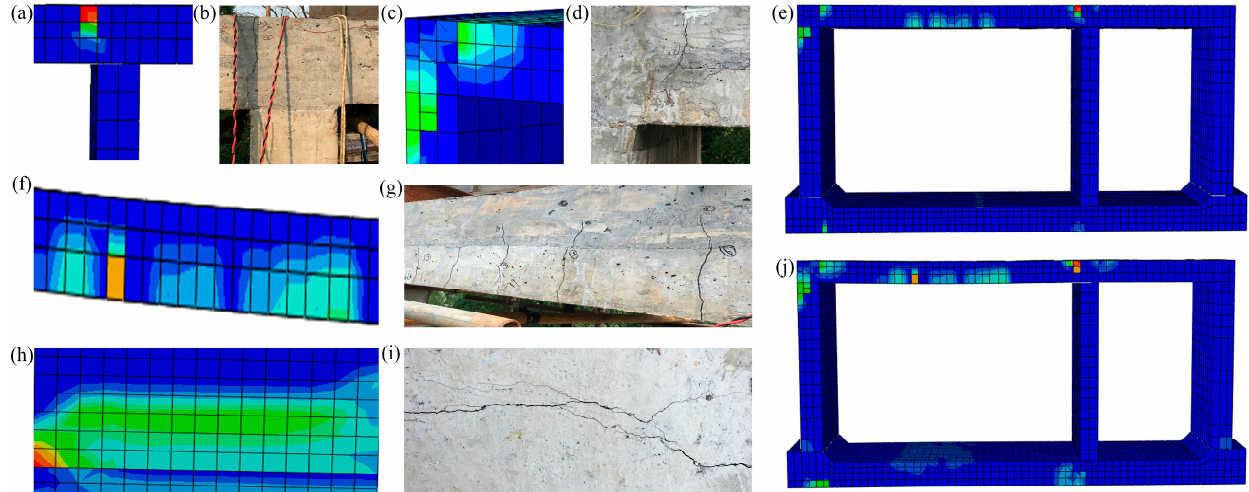
Figure 13. Crack simulation of prefabricated underground utility tunnel: ( a ) the crack near the middle joint for a finite element load of 560 kN; ( b ) the crack near the middle joint for a test load of 579 kN; ( c ) the crack in left joint of large-span top plate at finite element load of 579 kN; ( d ) the crack in left joint of large-span top plate at test load of 579 kN; ( e ) crack distribution at a finite element load of 579 kN; ( f ) through-length cracks along the section direction of large-span top plate with a finite element load of 794 kN; ( g ) through-length cracks along the section direction of large-span top plate with a test load of 794 kN; ( h ) through-length cracks along the section direction near the middle joint for a finite element load of 848 kN; ( i ) through-length cracks along the section direction near the middle joint for a test load of 848 kN; and ( j ) crack distribution at a finite element load of 940 kN.